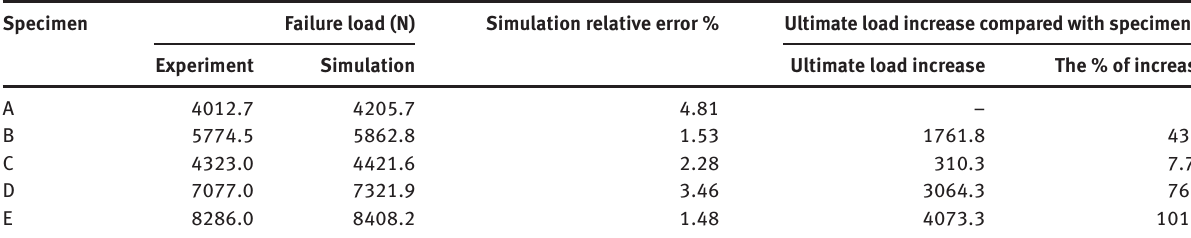
Table 5: The ultimate load comparison between simulation and experimental results.